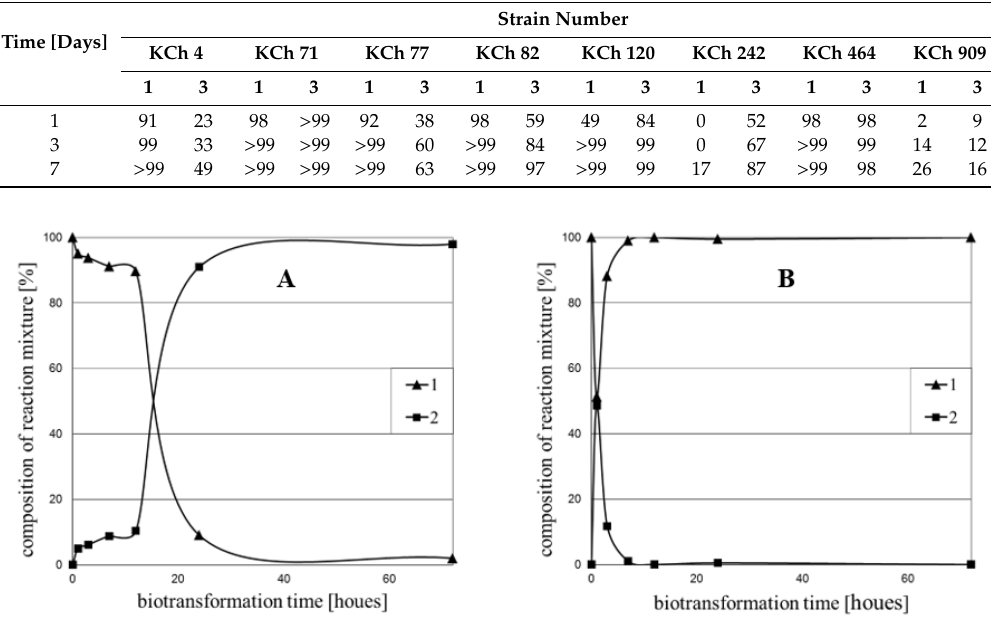
Table 1. Relationship between transformation of substrates 1 and 3 [%] and time in the cultures of Table 3. Transformation of the substrate 3 by selected strains. tested strains.